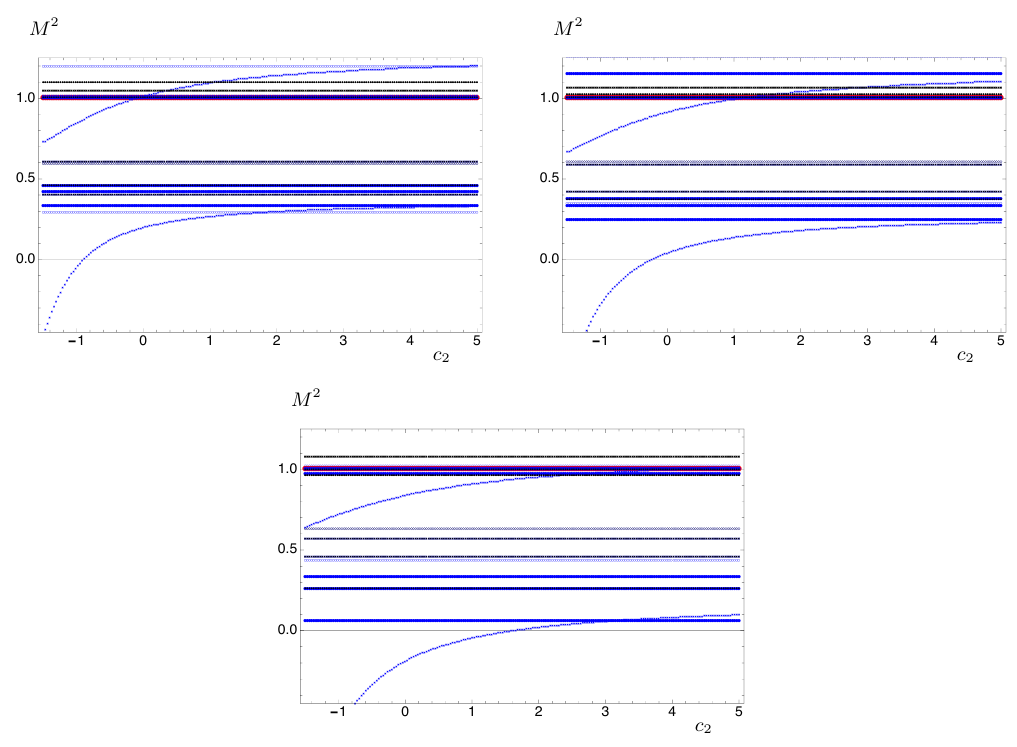
Figure 8 . Detail of the combined mass spectrum M 2 = − q 2 of all the bosons, for the choices of φ I = − 0 . 05 , 0 . 05 , 0 . 25 (top-left, top-right, bottom panels), obtained by varying the parameter c 2 defined in eq. (5.2). The colour and symbol coding is the same as in the earlier plots of the mass spectra. Numerical calculations use ρ = 10 − 10 and ρ = 10 1 2